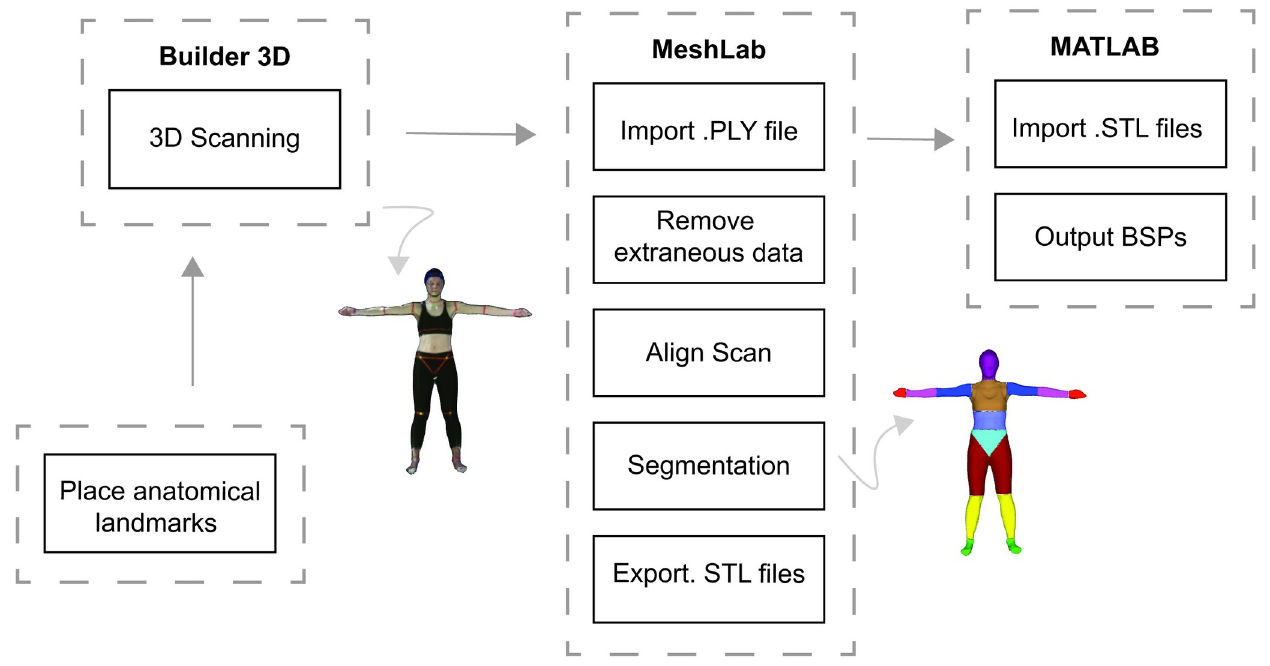
Fig 4. Overview of our workflow. After placing anatomical landmarks on the participant, we used a Microsoft Kinect V2 and Microsoft Builder 3D to collect repeated 3D body scans. We exported the acquired scans into MeshLab for removing extraneous data, globally aligning, and segmenting each scan into 16 body segments. We then wrote custom MATLAB scripts to estimate the BSPs of each body